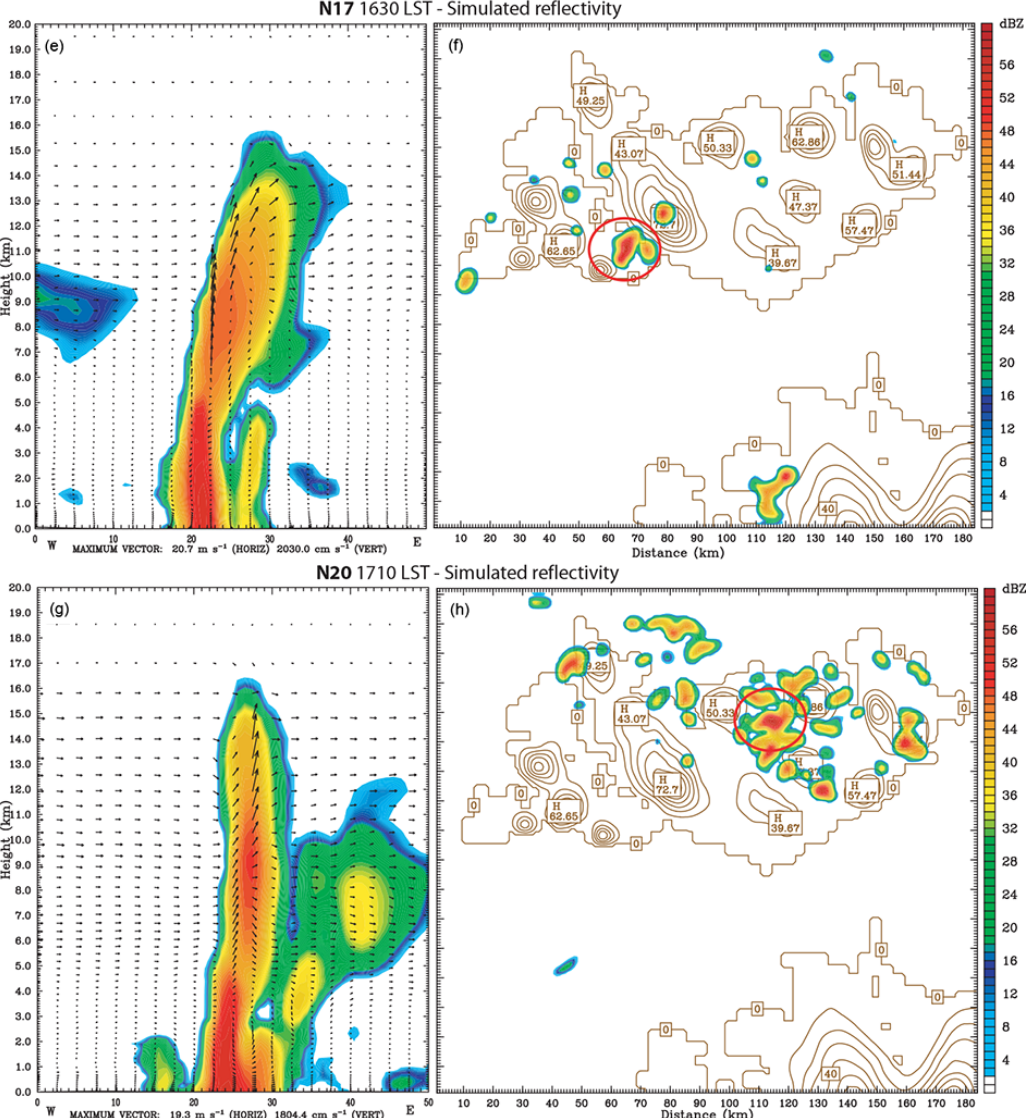
Figure 6. Sections at the maximum development of the Hector events N23, N11, N17 and N20. (a, c, e) Simulated vertical radar reflectivity (dBZ; filled color) and vertical wind, the section is taken longitudinally along the red circle reported in the right panel. (b, d, f) Horizontal radar reflectivity (dBZ; filled color) and topography